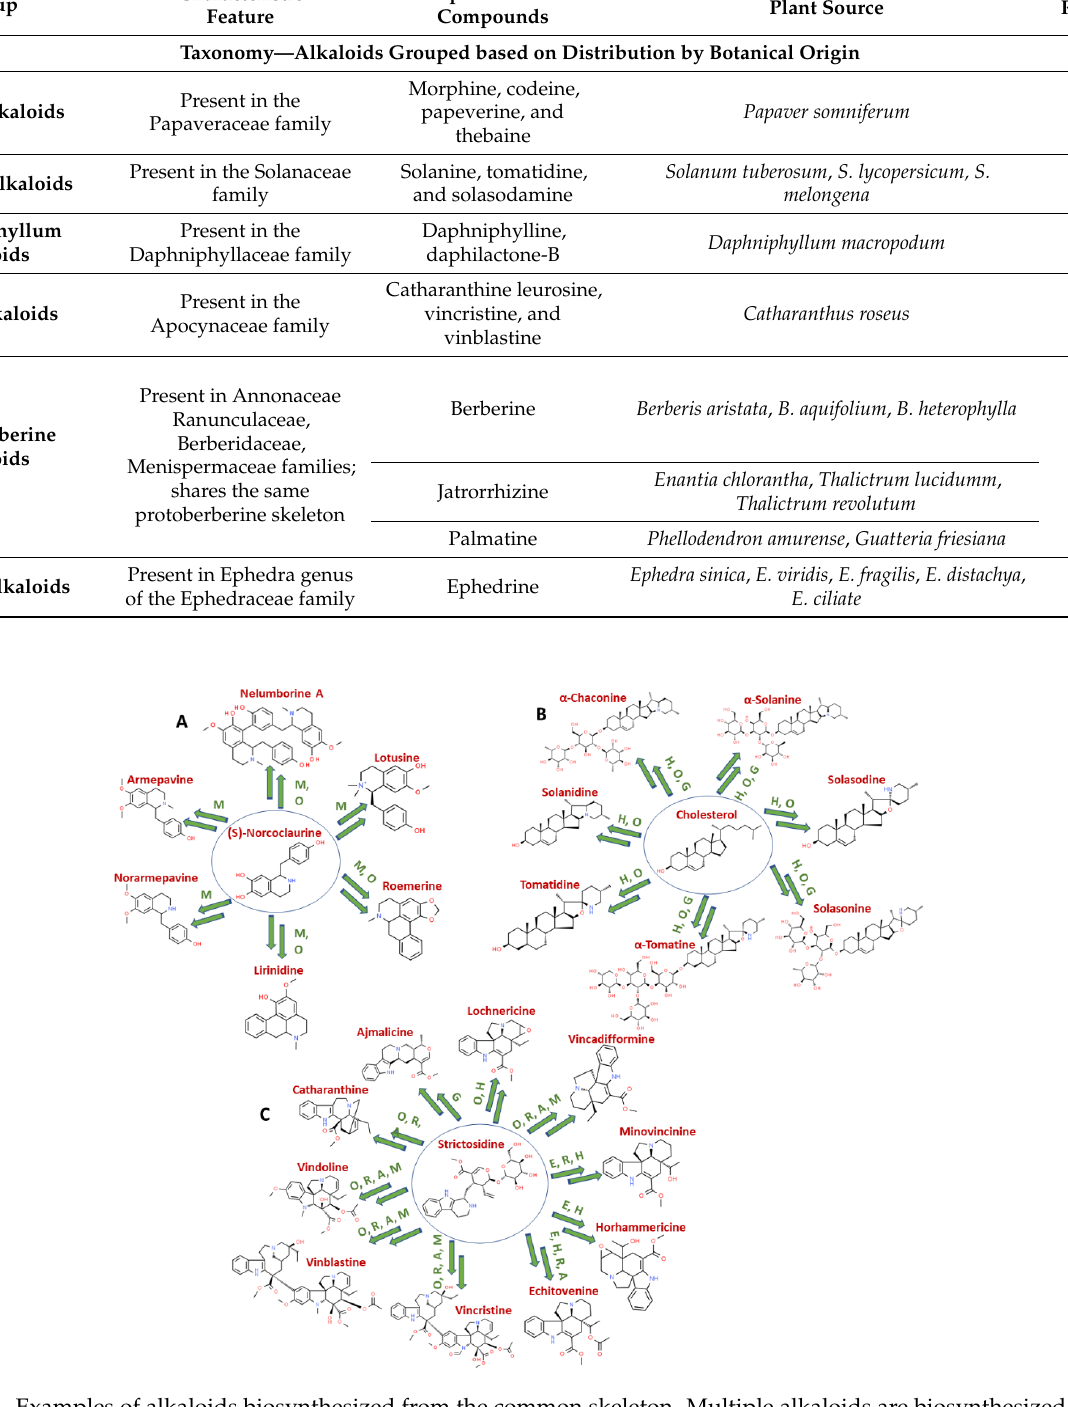
Figure 1. Examples of alkaloids biosynthesized from the common skeleton. Multiple alkaloids are biosynthesized from the common skeleton represented inside the blue circle in different plant species. ( A ) Benzylisoquinoline alkaloids in Sacred lotus; ( B ) Steroidal alkaloids and their glycosides in tomato, potato, and eggplant; ( C ) Terpene indole alkaloids in C. roseus . The common skeleton undergoes multiple enzymatic conversions (M = methylation, O = oxidation, R = reduction, G = glycosylation, A = acetylation, H = hydroxylation, and E = epoxidation) represented by multiple arrows to form a variety of alkaloids. Key enzymatic reactions that are reported have been mentioned beside the arrows. The chemical structures of alkaloids are drawn from “ChemSpider: the Free Chemical Database”.